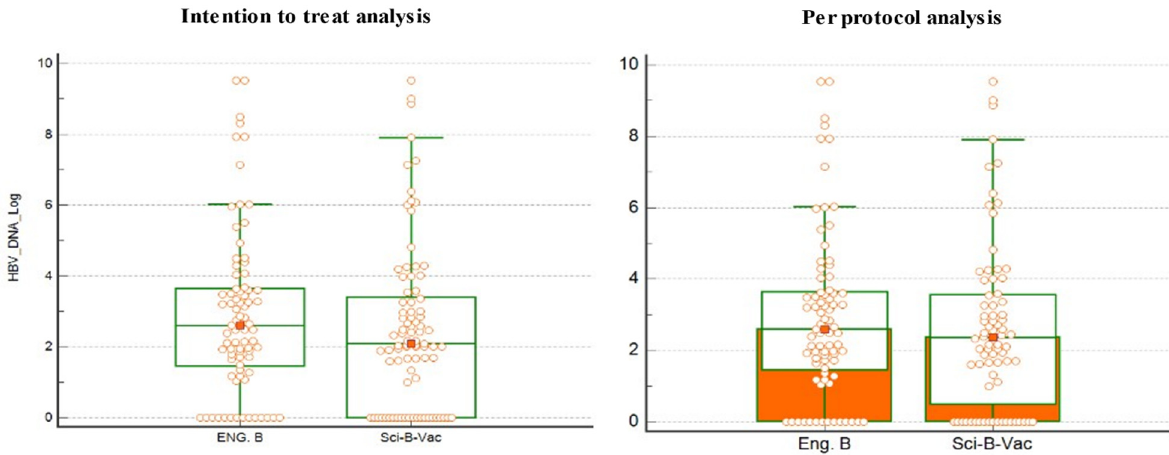
Figure 2. The median and interquartile range (IQR) of maternal hepatitis B virus (HBV) DNA viral load measurement at delivery. There was no significant difference in the log10 median. Eng. B, Engerix-B. Wilcoxon rank-sum was used to compare the median values.